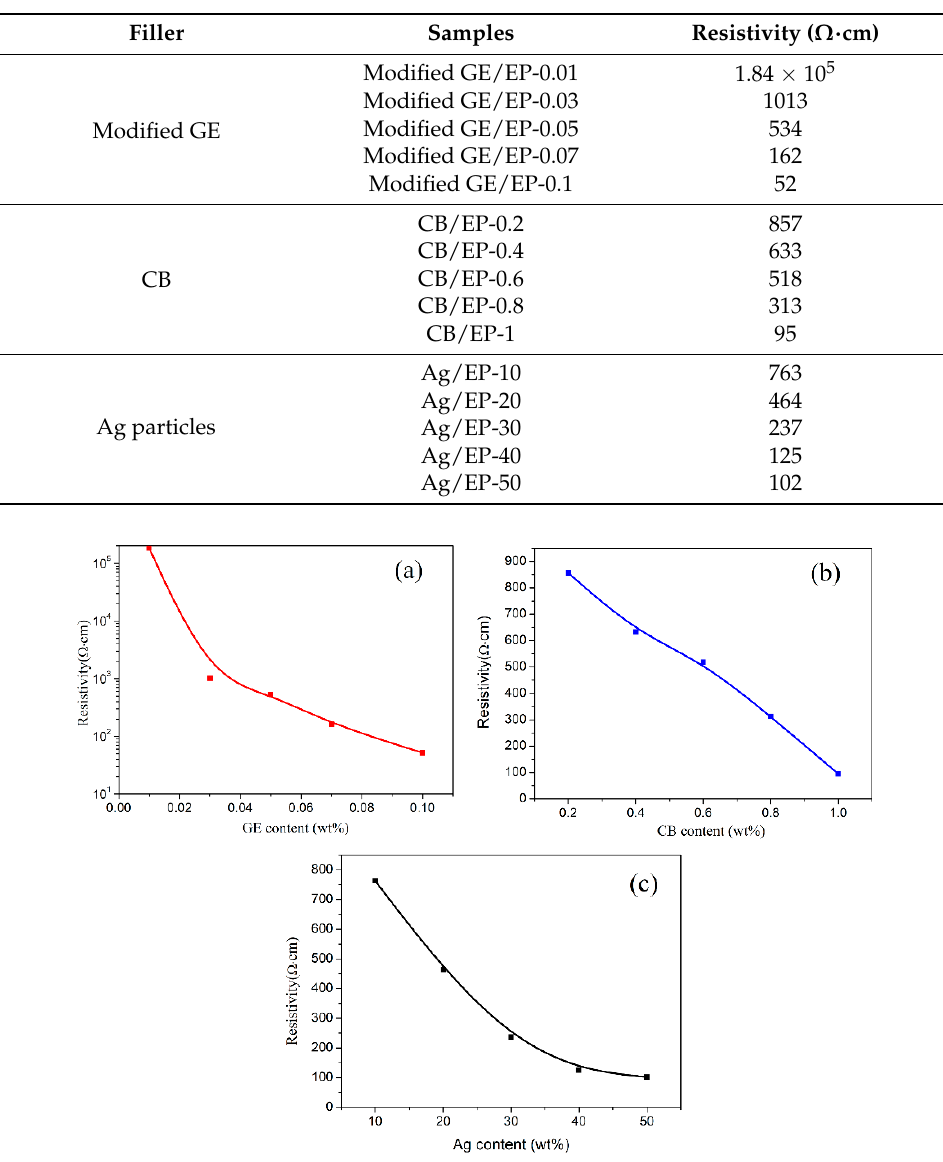
Table 1. The resistivity of modified GE/EP, CB/EP, and Ag/EP composites with different contents of fillers.